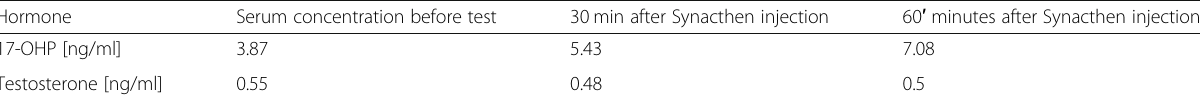
Table 2 The results of Synacthen test (intravenous, conventional-dose short test with 250 μ g of synthetic adrenocorticotropic hormone) in patient II:3